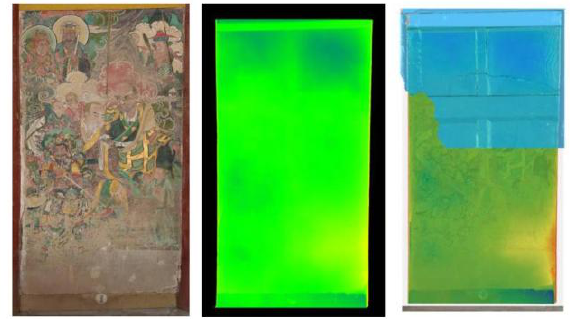
Figure 2024 A scan of the back of the mural wall indicates the structure of the bamboo inside is deforming